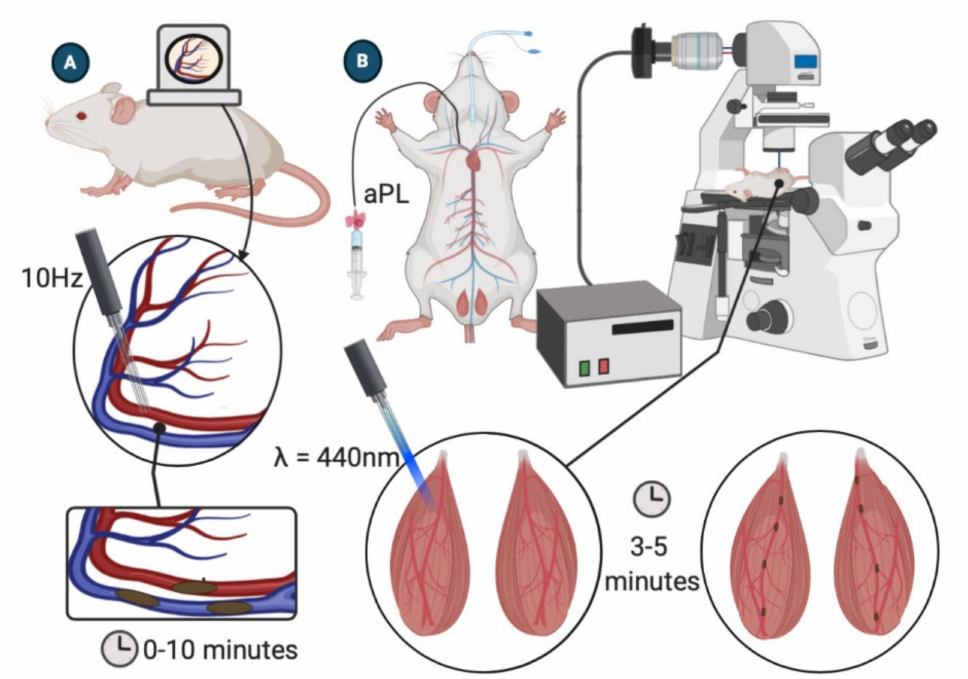
Figure 3. APS models of microcirculatory thrombosis. ( A ) Dorsal skinfold chamber model. Subcutaneous vasculature is visible through DCS window. A 10 Hz pulse laser s directed at the vessel wall for 30 s. Thrombosis is observed over the next 10 min [27,28]. ( B ) Laser-induced injury of the cremaster arterioles. Cremaster arterioles are exteriorized onto an intravital microscope tray. A laser is focused through the microscope objective and aimed at a selected vessel wall. Thrombosis is recorded via intravital fluorescent microscopy